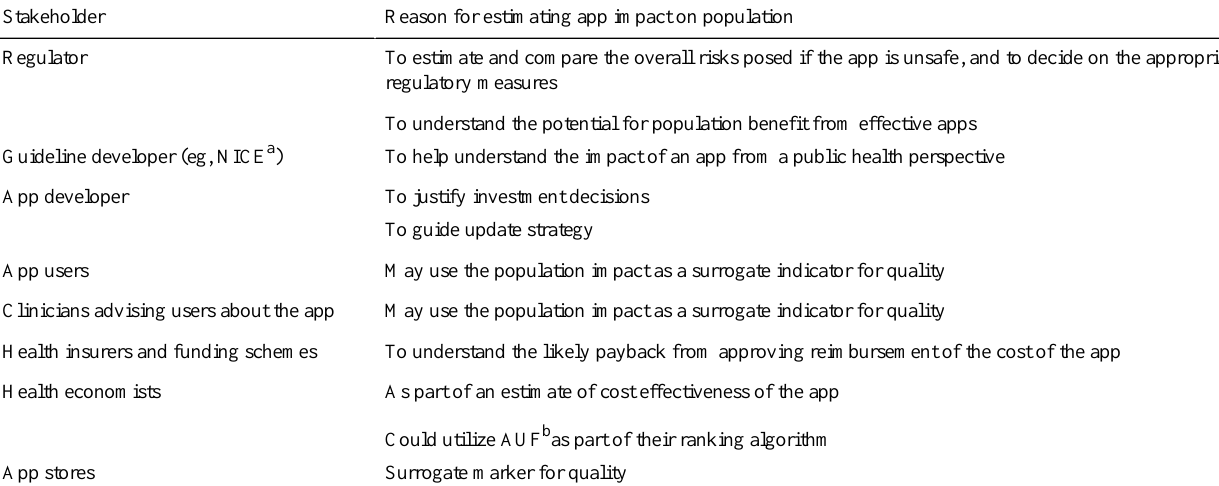
Table 2. Key reasons for use of population impacts of mobile apps by